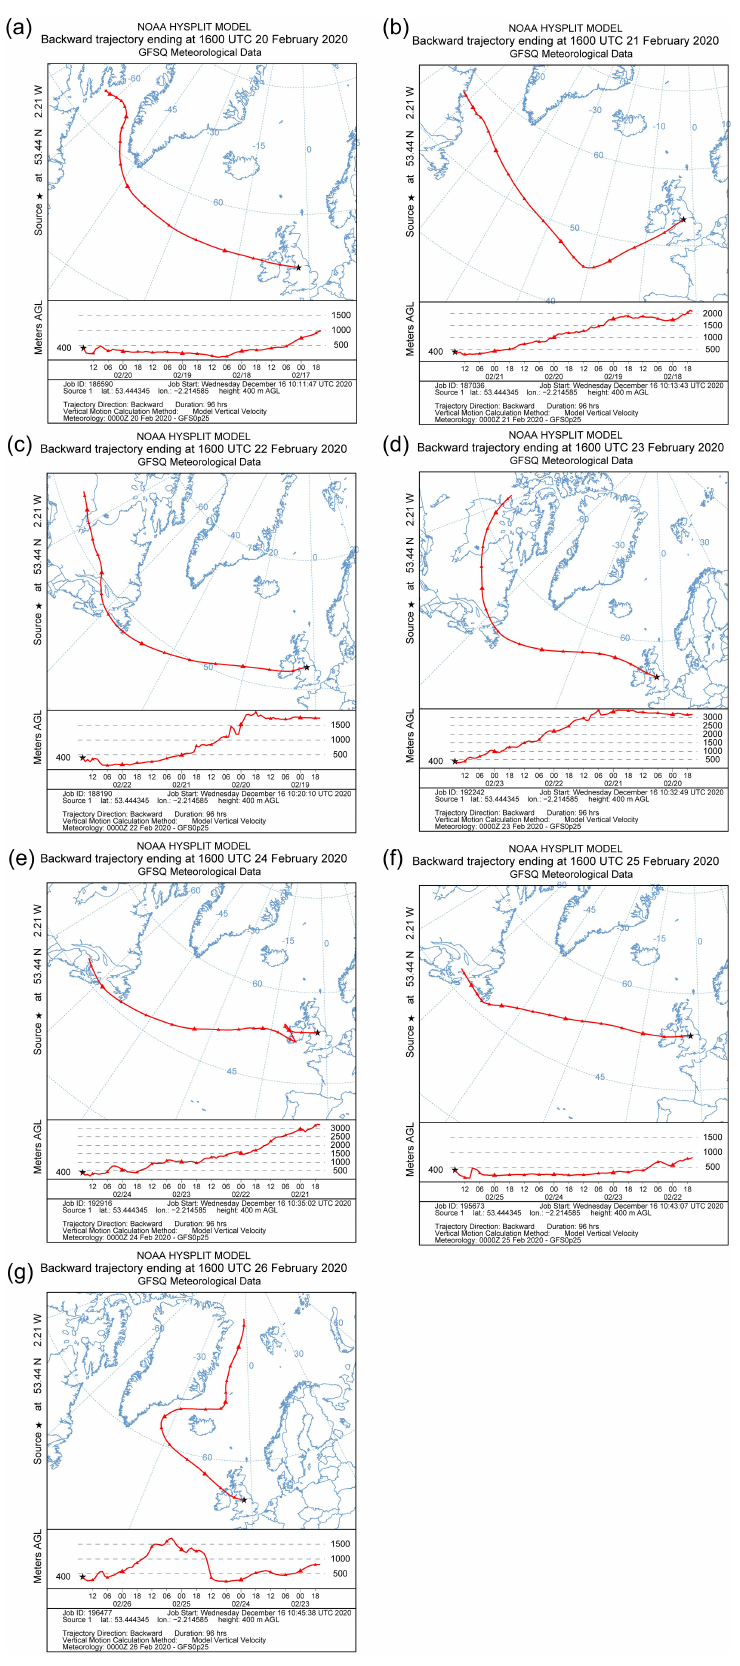
Figure 3. 96 h HYSPLIT Lagrangian back trajectories of air at the start point of each sample collected in February 2020. ( a ) “FIRS2_2”, ( b ) “FIRS2_3”, ( c ) “FIRS2_4”, ( d ) “FIRS2_5”, ( e ) “FIRS2_6”, ( f ) “FIRS2_7” and ( g )